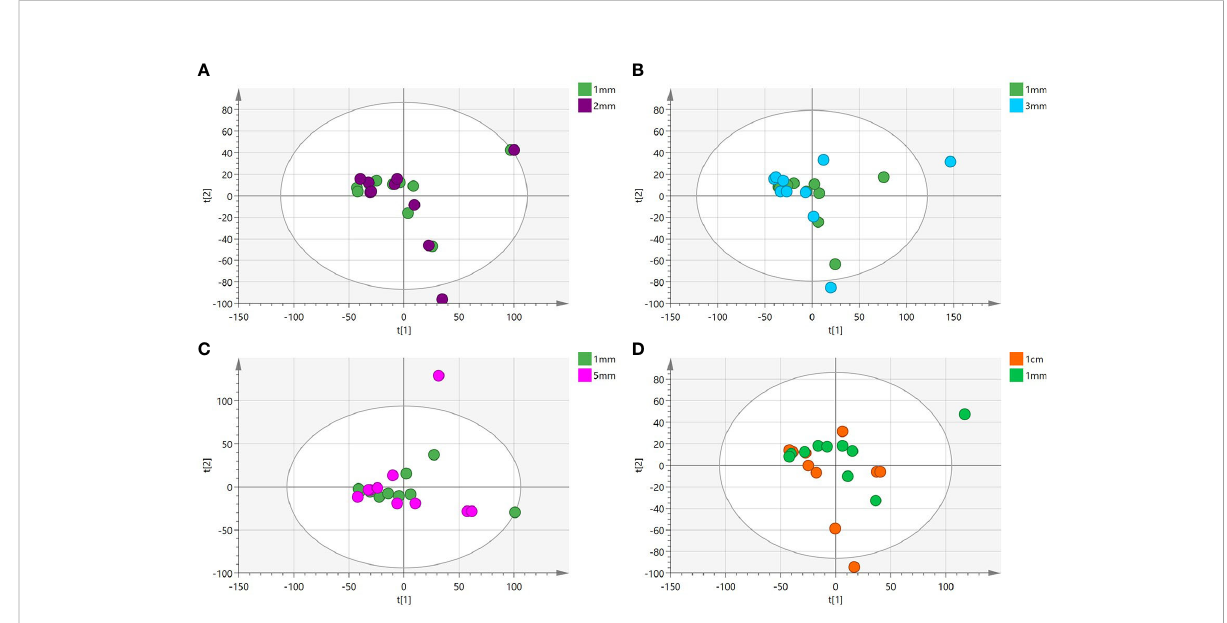
FIGURE 3 (A-D) Principal component analysis(PCA) plot comparing between tissue located at the 1mm surgical margin and other surgical margins.